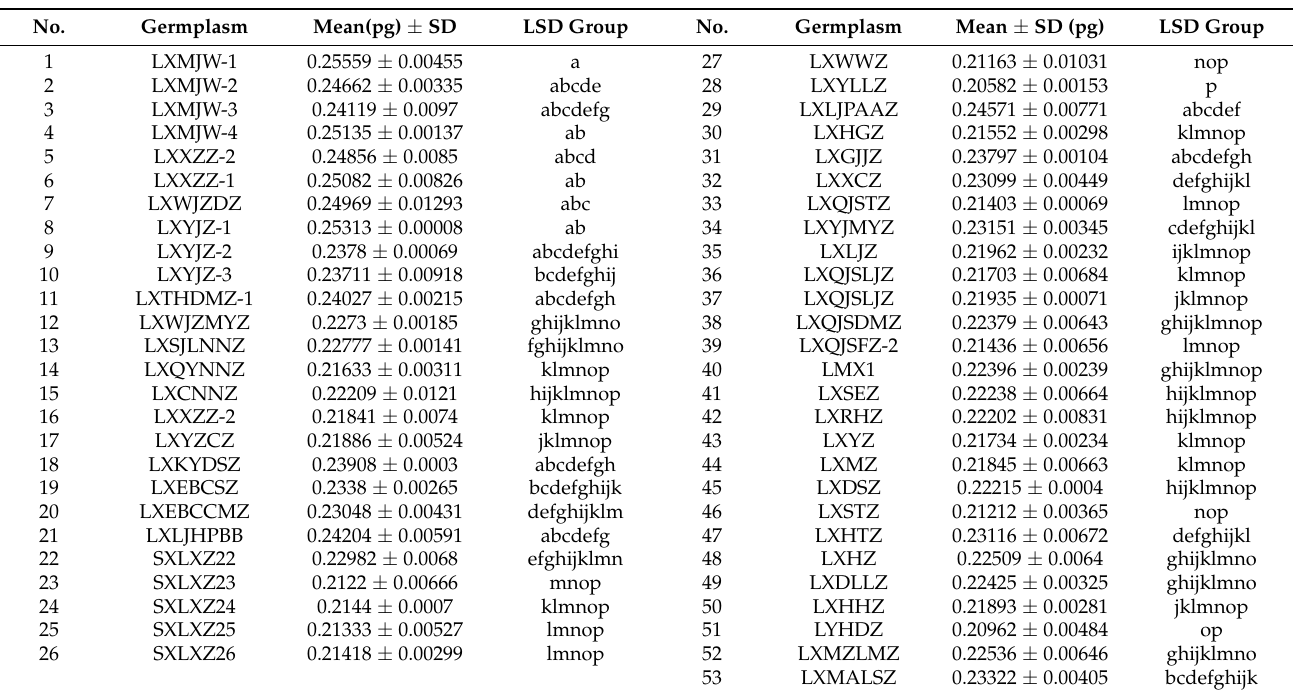
Table 1. Analysis of least significant differences (LSDs) in the genomic C-values of jujube in Linxian